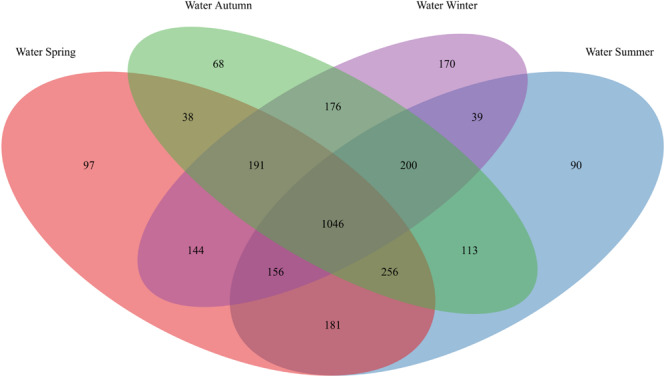
OTU overlap of seawater bacterial communities among seasons. Venn diagram illustrating the counts of OTUs shared by seawater (“Water”) bacterial communities among spring, summer, autumn, and winter.